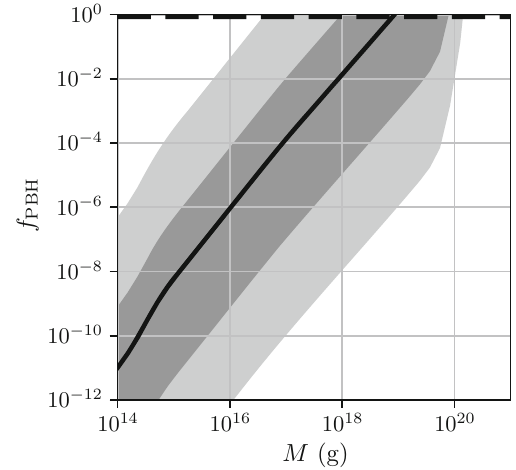
Fig. 7 Schematic PBH constraints for all extremal assumptions α tot (light grey area) and with only the extremal fidutial instrument charac- teristics α i ) (dark grey area), compared to the fidutial case (dark solid